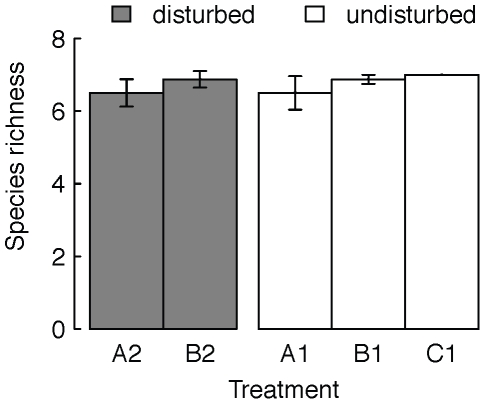
Mean species richness at the end of the experiment.Mean species richness (±se) within single communities in undisturbed and disturbed patches (white and grey bars respectively). A1 and A2 were isolated patches, while B1, B2 and C1 were connected patches (see also Fig. 1).